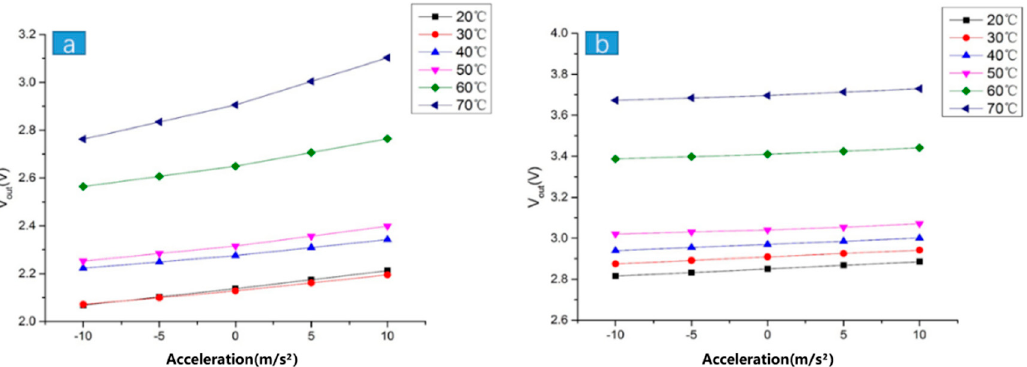
Figure 21. Relationship between the acceleration value and output voltage at different temperatures: ( a ) before packaging; ( b ) after packaging.